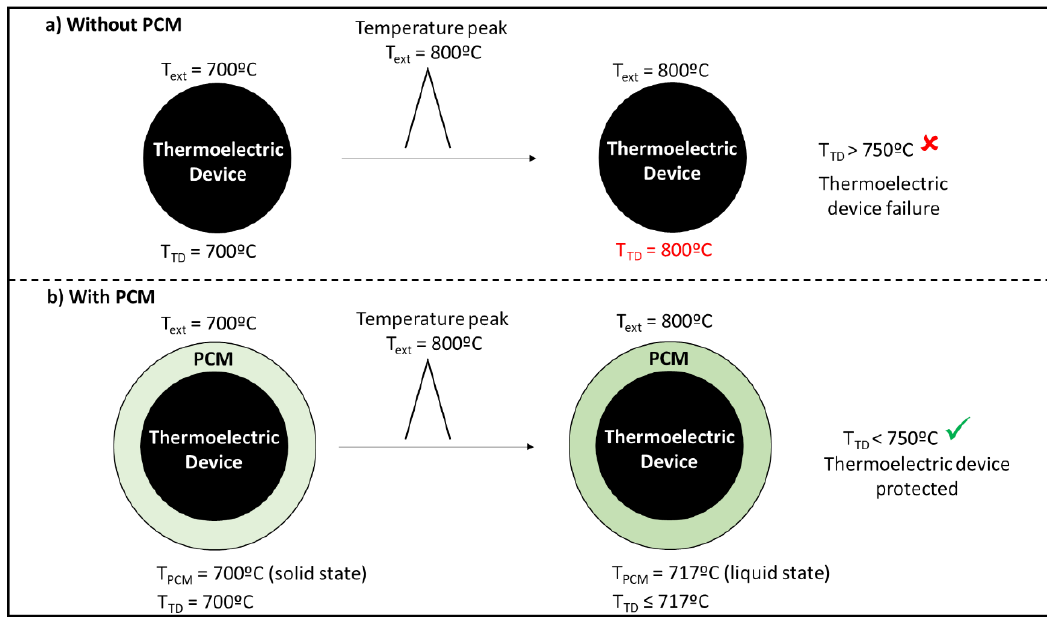
Figure 9. PCM work scheme.